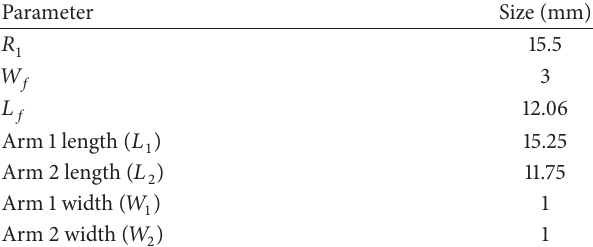
Table 2: Dual-band antenna